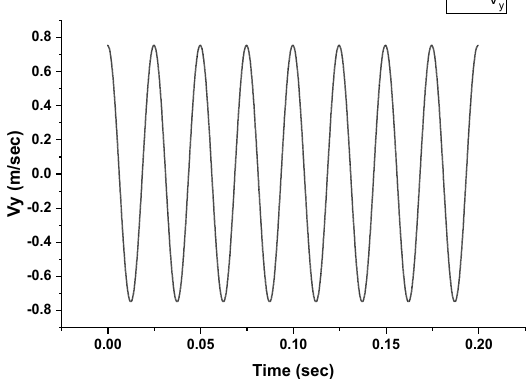
Figure 4. Sinusoidal motion curve produced by MATLAB.